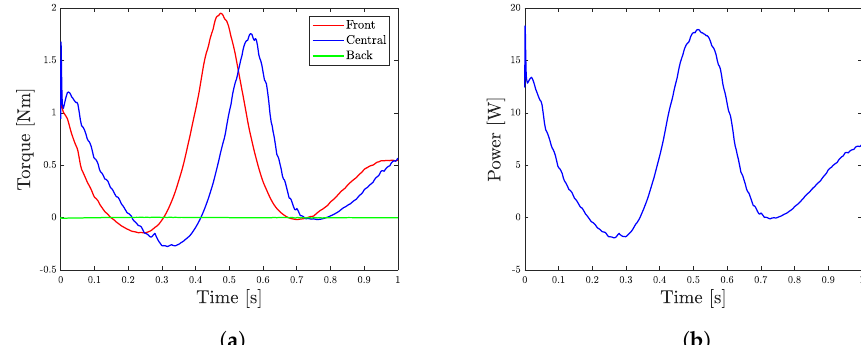
Figure 17. Torque required by the motors ( a ) and power consumed by the robot ( b